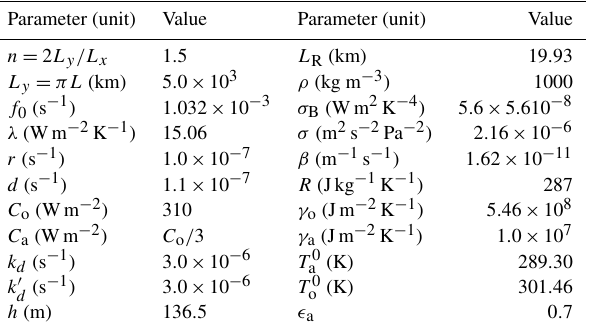
Table 1. Values of the parameters of the model that are used in the analyses of Sect.